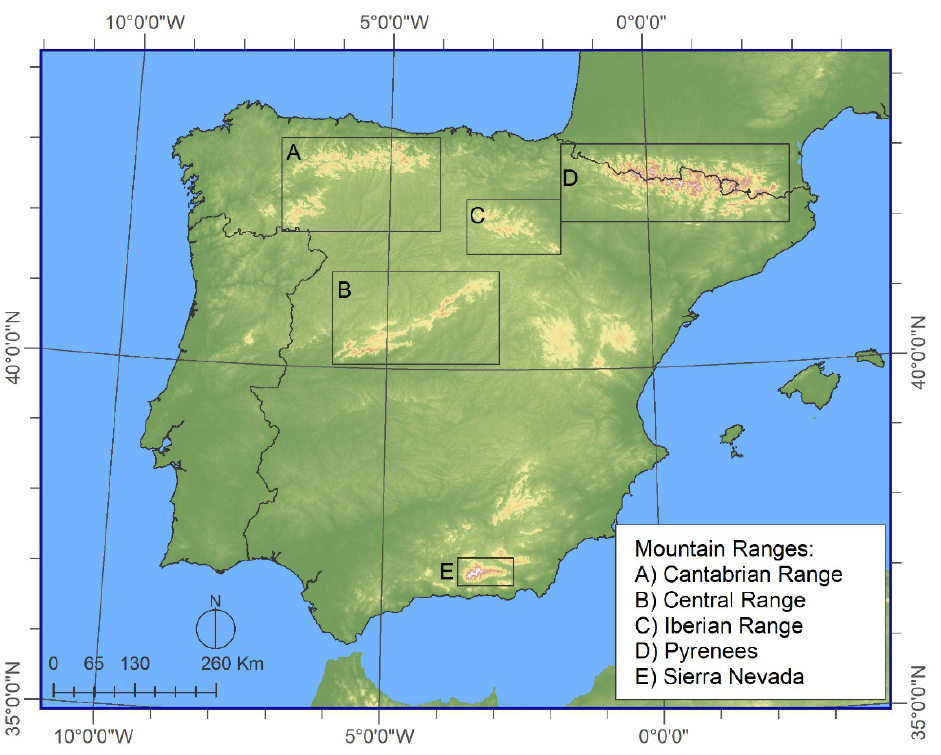
Figure 1. Geographical locations of the main mountain ranges of the Iberian Peninsula.